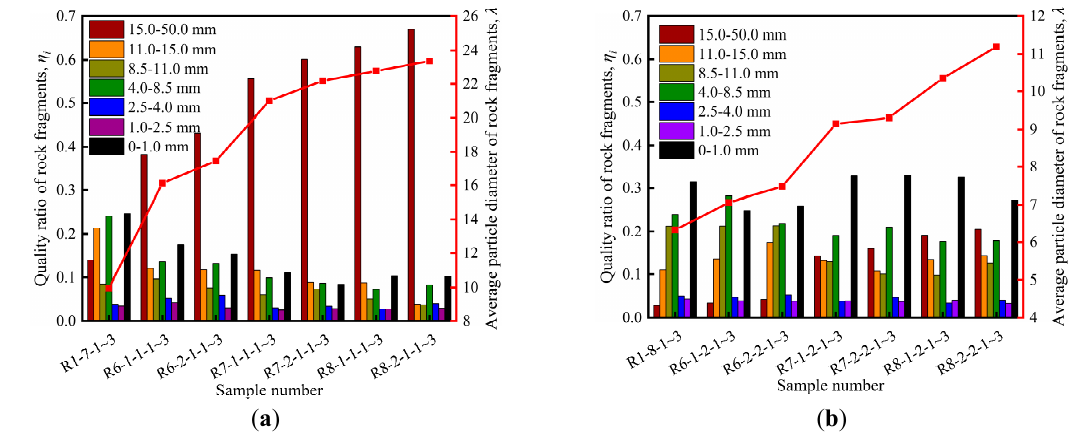
η , and the average particle diameter of i